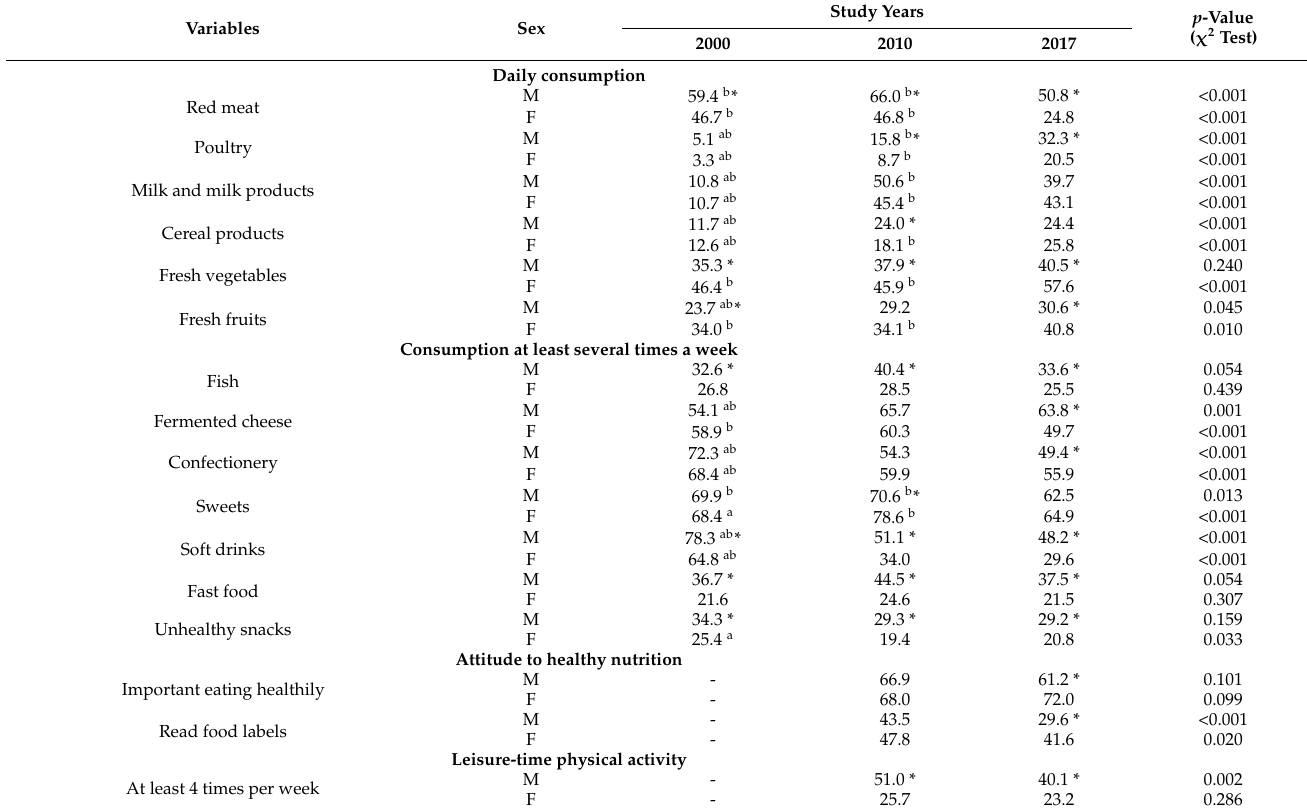
Table 5. Changes in students’ eating habits, attitude to healthy nutrition and physical activity (%) between 2000 and 2017.